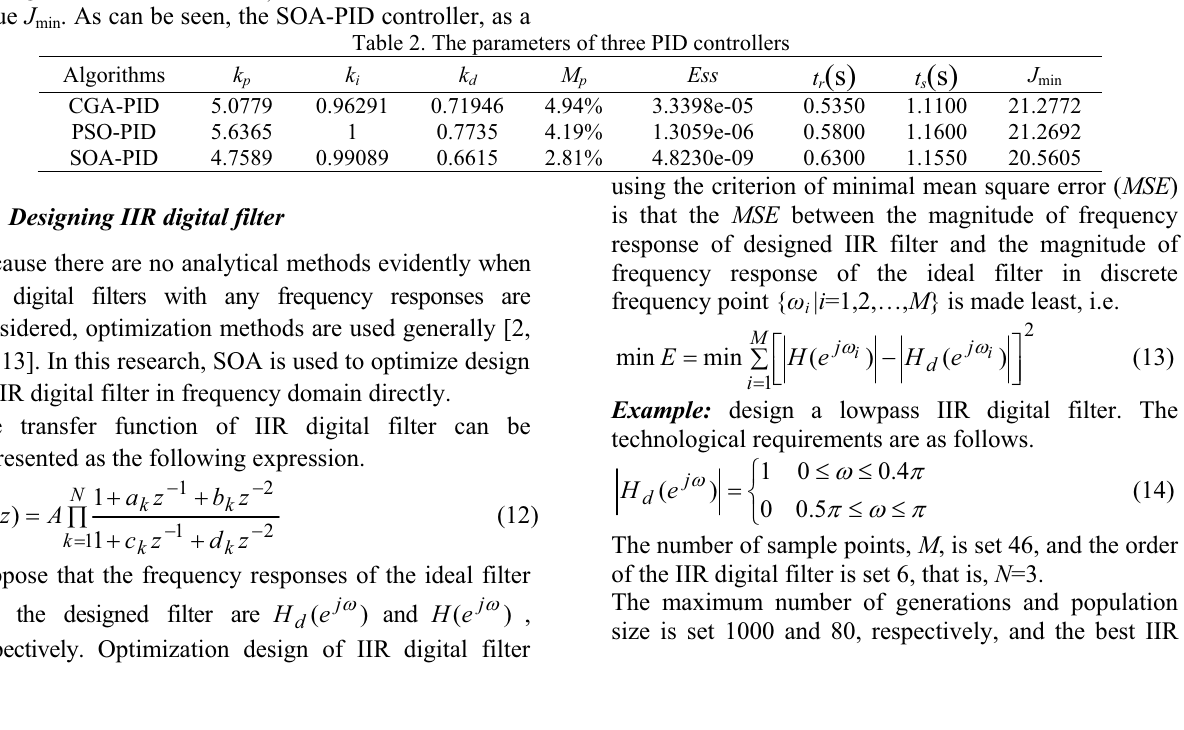
Figure 3. Step response curves of three PID controllers